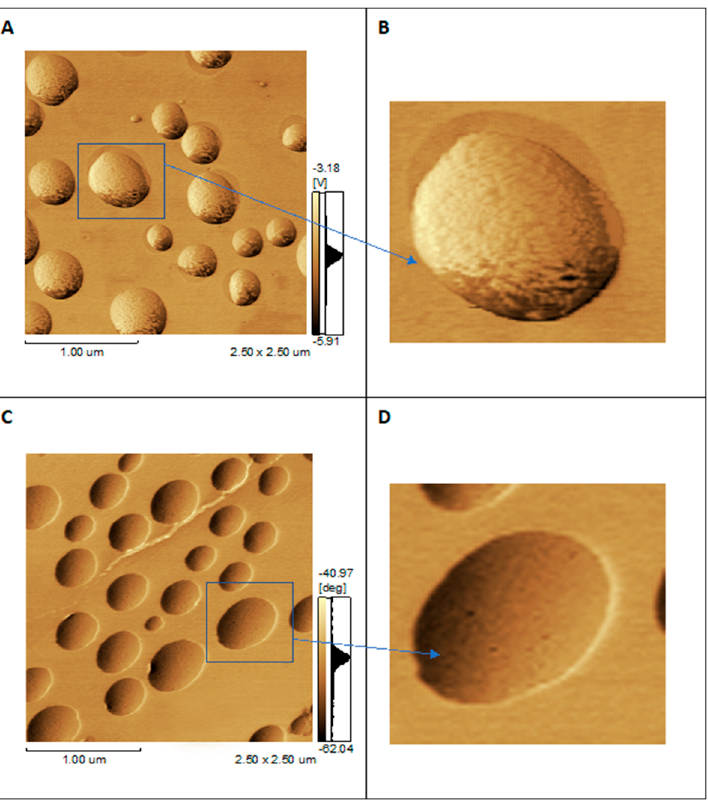
Figure 2. AFM phase images of 9:1 DPPC:DPPS (molar ratio) vesicles (0.6 mg mL − 1 ) of ( A ) liposomes (2.5 × 2.5 μ m scales); ( B ) zoomed detail of only one vesicle; ( C ) proteoliposomes harboring AnxA5 (1:100 protein:lipid, molar ratio) (2.5 × 2.5 μ m scales); ( D ) zoomed detail of only one vesicle.